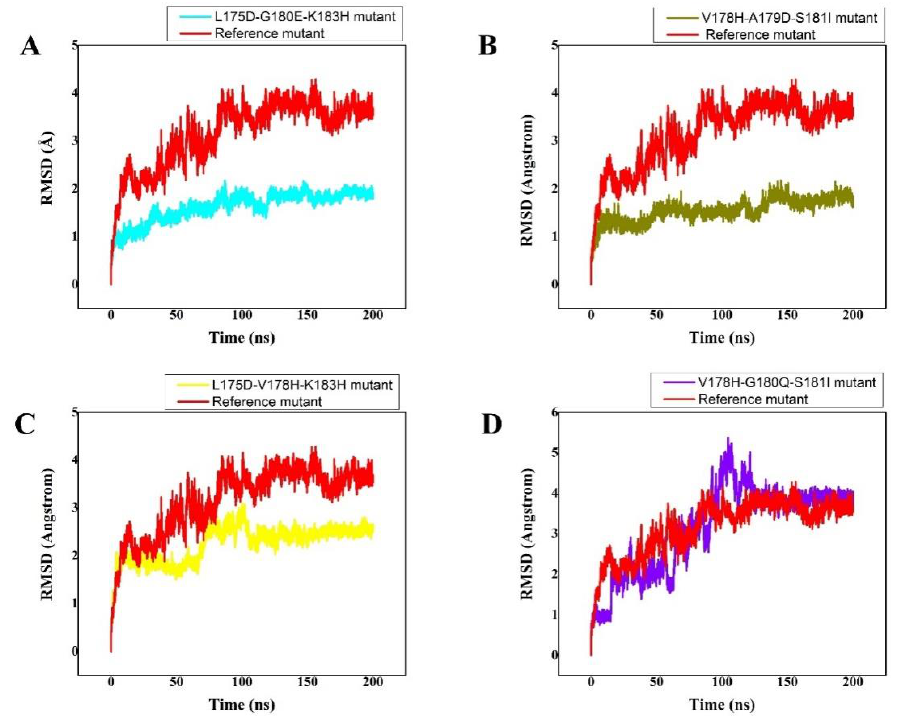
Figure 1. ( A – D ) Root mean square deviation (RMSD) of the backbone atoms of reference peptide/K-Ras mutant complex and its designed peptides/K-Ras mutant complexes: The X, Y plots show the time-dependent RMSD behaviour from the initial state to over a 200 ns trajectory. This figure shows the dynamic stability of each system as RMSD. The color scheme shows their respective trajectory. The reference peptide/K-Ras mutant complex is shown in red while the ( A – D ) designed peptides/K-Ras mutant complexes are shown in cyan, olive green, yellow, and purple, respectively. The x -axis shows time in nanoseconds while the y -axis shows RMSD in Angstrom.